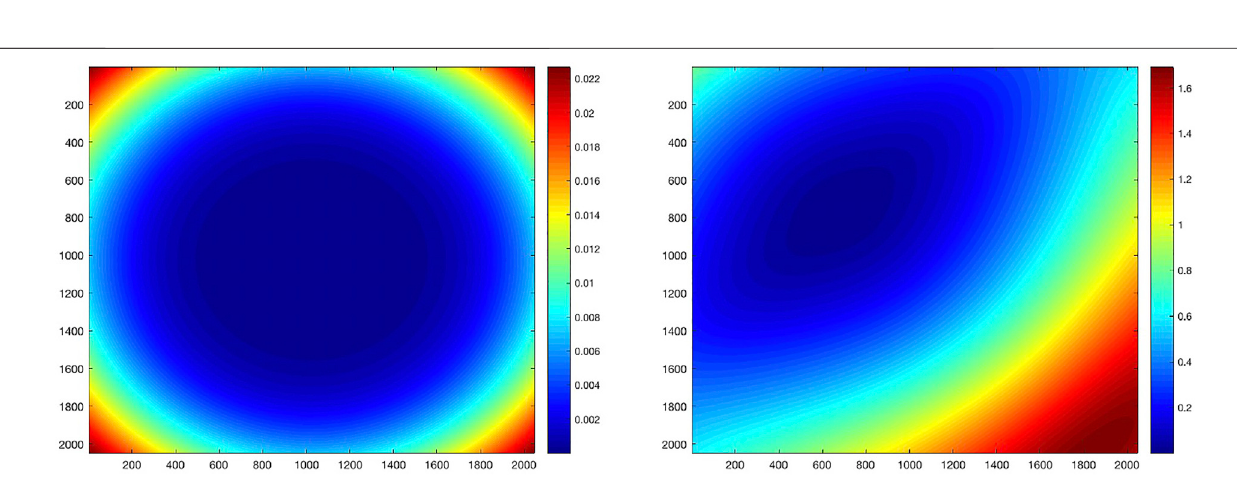
Frontiers in Remote Sensing |